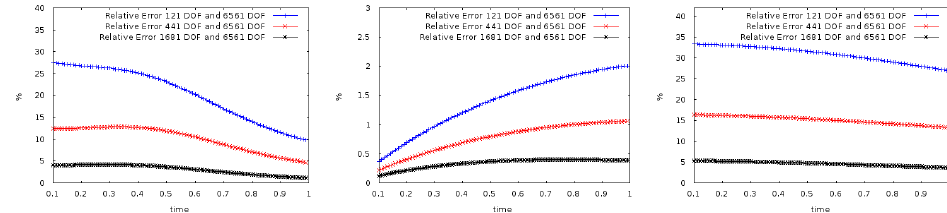
Figure 9. Relative L 2 errors in % for the reference mesh (6561 vertices) with other meshes (121, 441, and 1681 vertices) for the first and second continuum and displacement (from left to right